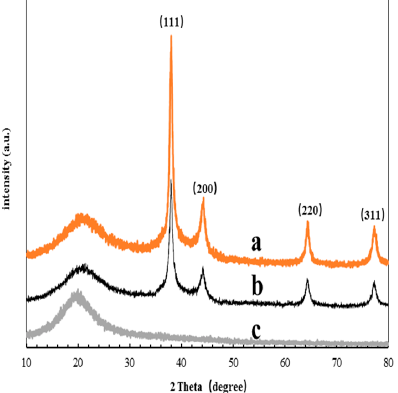
Figure 5. XRD patterns of the prepared polymer reactors. ( a ) AgHBP-A; ( b ) HBP-A; ( c ) AgHBP-N.